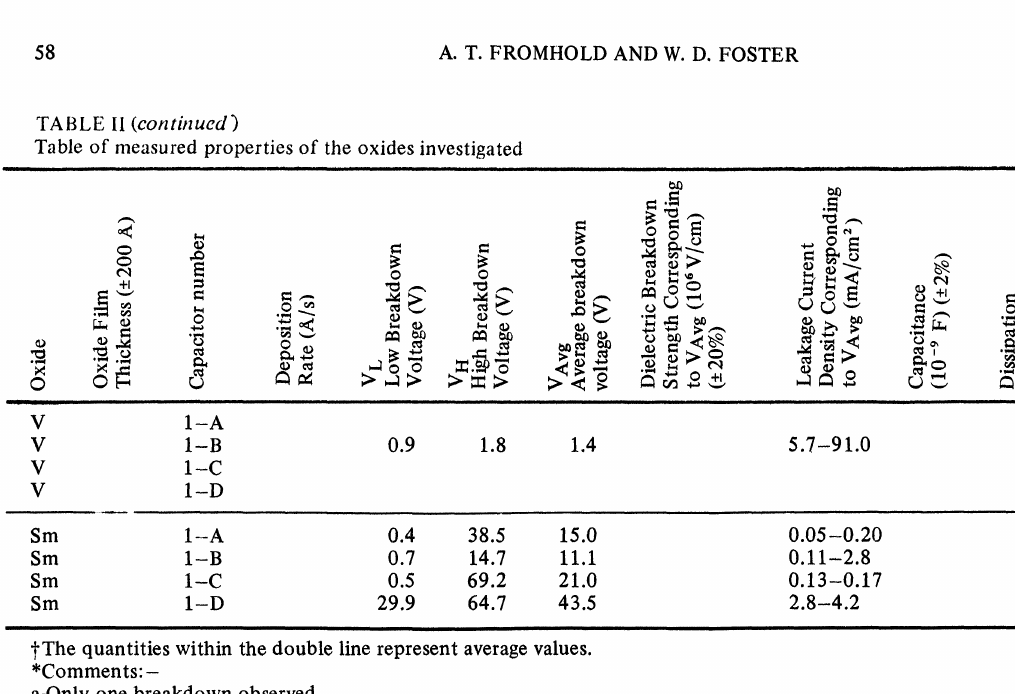
TABLE II (conthtued) Table of measured properties of the oxides